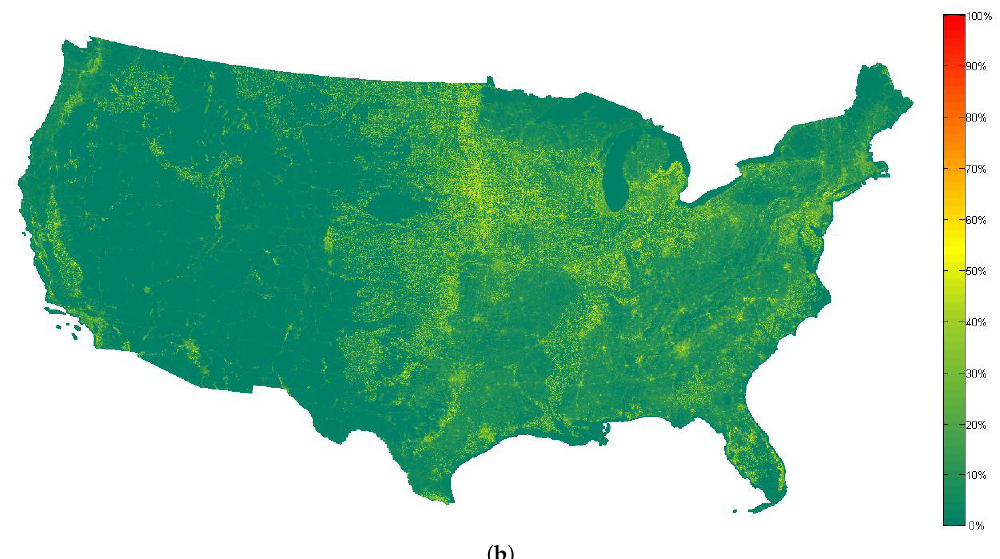
Figure 23. Similarity maps (with a resolution of 3 km) of the reference scene (Figure 21a).